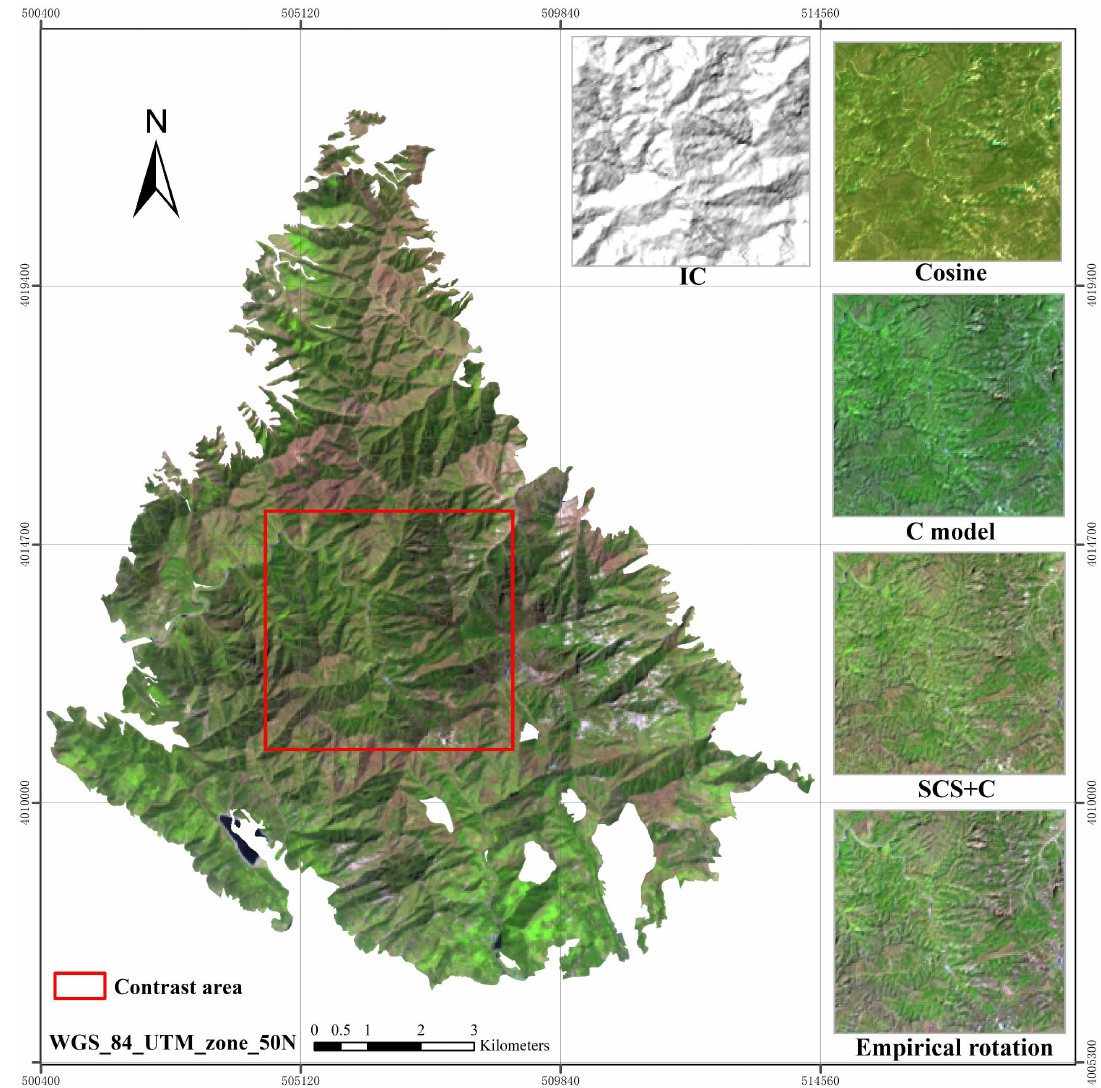
Figure 3. Comparison of Landsat 8 surface reflectances before and after topographic correction. The contrast area represents the region of Illumination conditions’ data and topographic correction data (R: shortwave infrared 1 (SWIR1), G: near infrared (NIR) and B: red; data date: 26 March 2016).